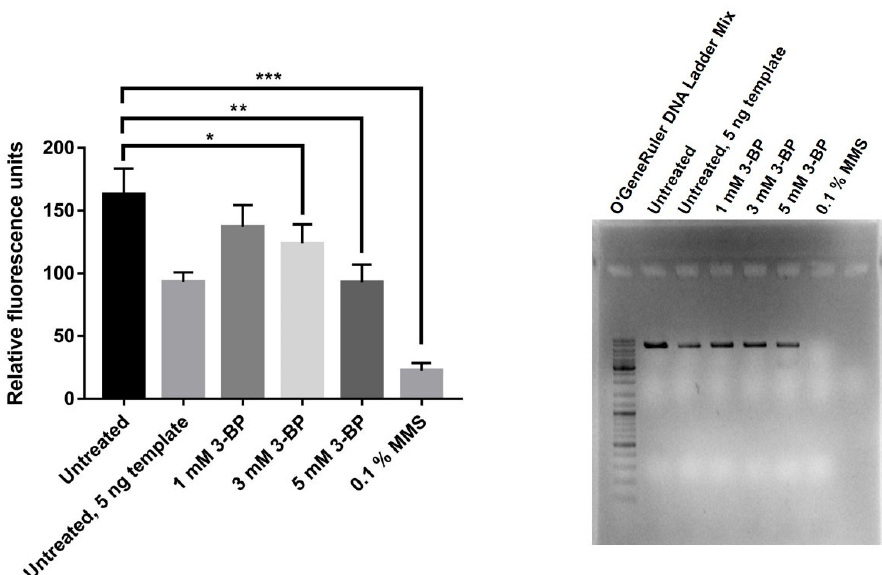
Figure 5. 3 ‐ BP causes an increase in mtDNA lesions detected in the QPCR assay. Logarithmically growing WT cells were treated with indicated 3 ‐ BP concentrations and 0.1% MMS for 5 h and DNA was extracted from cells. DNA concentrations were adjusted and PCR was run to amplify 6.9 kb fragment of mitochondrial COX1 gene. dsDNA content was measured with QuantiFluor (Promega). PCR products were visualized with agarose gel electrophoresis. * p ≤ 0.05; ** p ≤ 0.01; *** p ≤ 0.001.